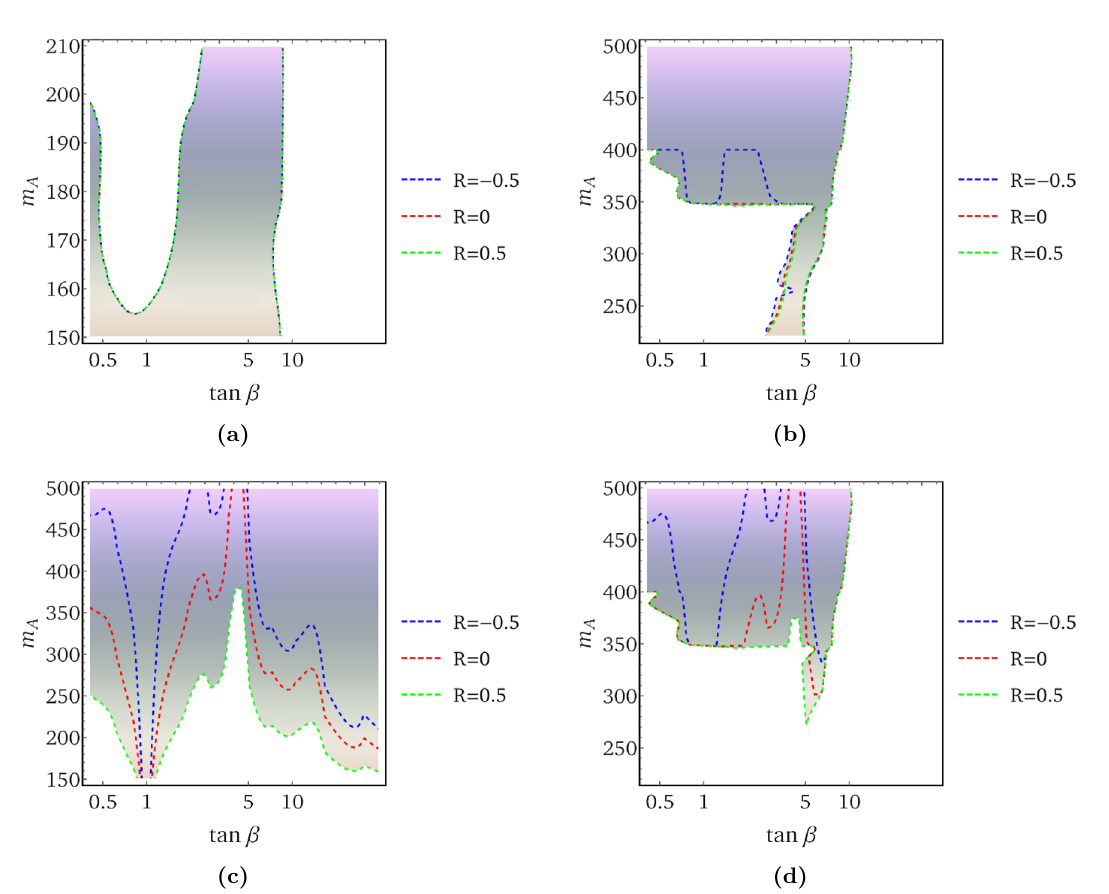
Figure 2. Bounds for Type-II Yukawa couplings. Regions ruled out by (a) A/H → ττ data, (b) combination of collider constraints, including A/H → ττ , (c) precision Higgs global fits, and (d) combination of collider bounds and precision Higgs global fits. Each panel shows three different R curves; the white regions of the parameter space are ruled out. In panels (b)–(d), the ruled out areas expand somewhat as R decreases, with the borders of the allowed shaded regions indicated by the corresponding contours. There is a different m A scale in panel (a) as compared to the other three panels because the A → γγ and A → Zh bounds are restricted to m A & 220 GeV